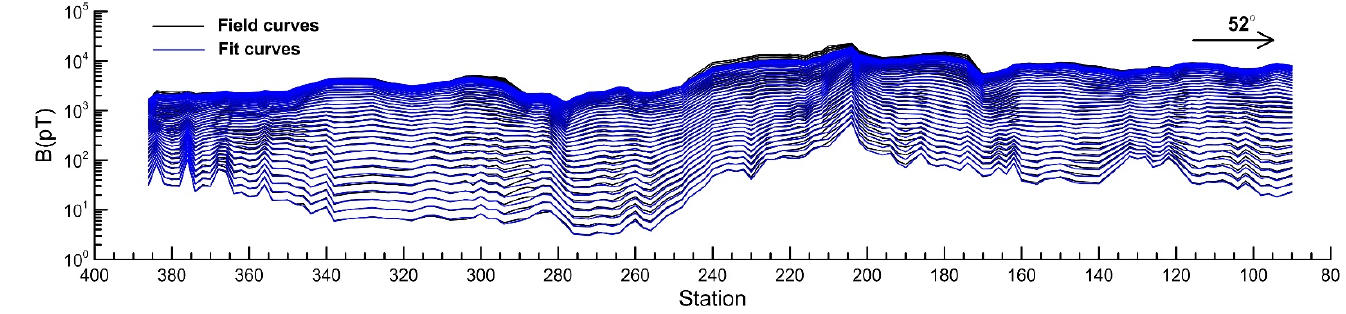
Figure 6. Plot curves of SQUID magnetometer TEM data.